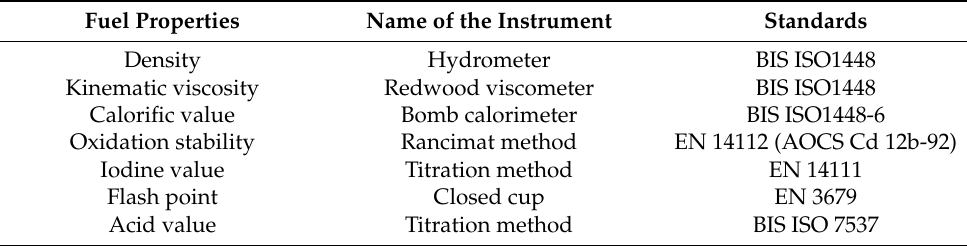
Table 1. List of the equipment and standards used for fuel